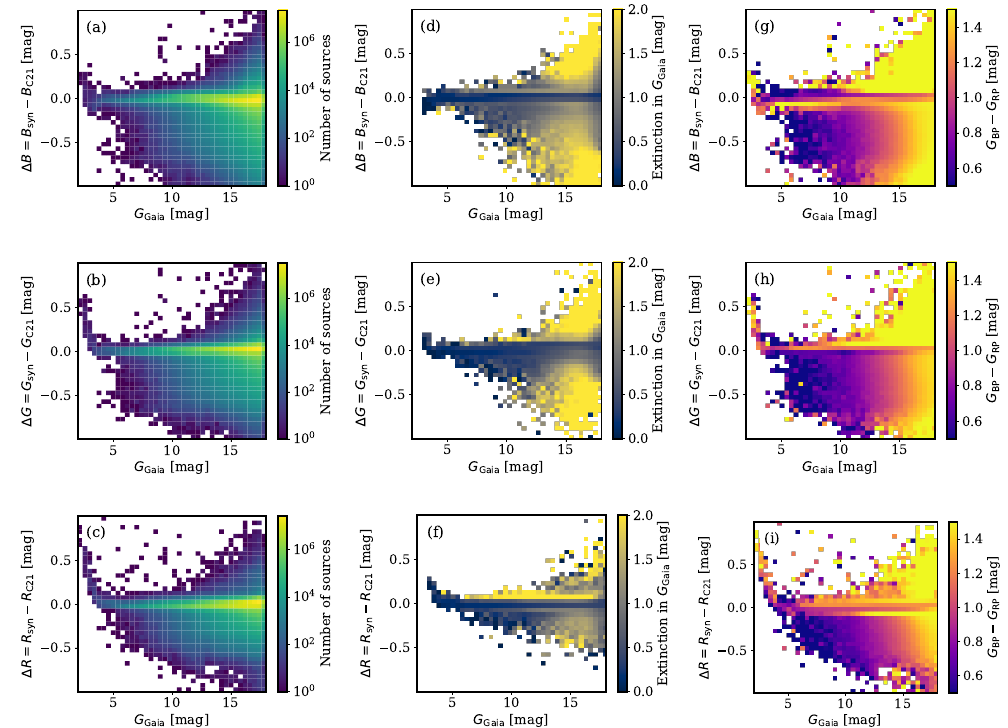
Figure 13. 2D histograms representing the number of sources (left column, panels ( a – c )), the extinc- tion in G Gaia (middle column, panels ( d – f )) and the colour G BP − G RP (right column, panels ( g – i )) as a function of G Gaia (the horizontal axis; using 0.4 mag bins) and ∆ X = X syn − X C21 = 0 mag with X= B RGB , G RGB and R RGB (the vertical axis; employing 0.05 mag bins). Each row displays the results for the B RGB , G RGB and R RGB bands (from top to bottom, respectively). These plots are an expanded version of the blue histograms shown in Figure 12, i.e., we are using the subset of the 200 M sample verifying − 0.5 ≤ G BP − G RP ≤ 2.0